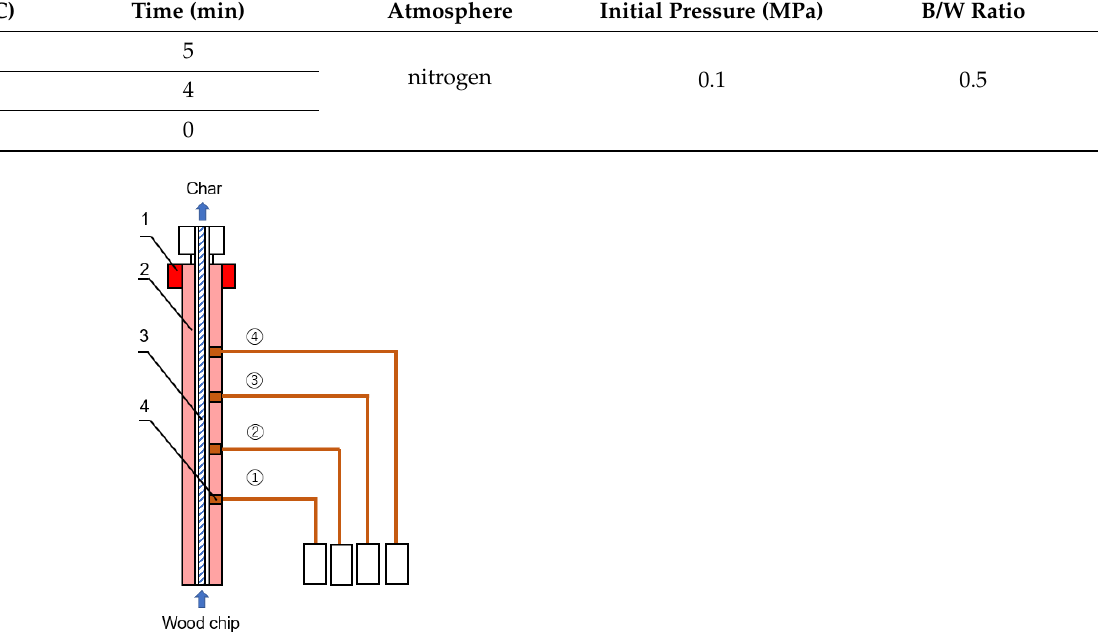
Figure 3. Continuous pyrolysis reactor. 1: heating part; 2: heat conduction part; 3: screw; 4: outlet.